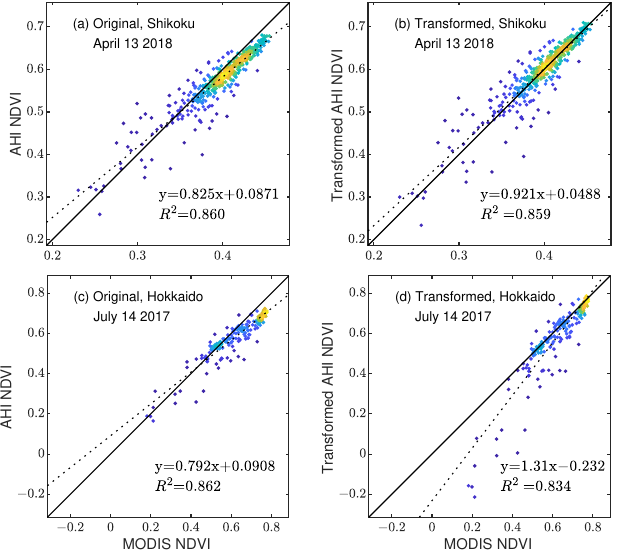
Figure 9. Density scatter plot of the aggregated NDVIs: ( a ) AHI vs. MODIS NDVI for Shikoku, April 13 2018; ( b ) transformed AHI vs. MODIS NDVI for Shikoku, April 13 2018; ( c ) AHI vs. MODIS NDVI for Hokkaido, 14 July 2017; and ( d ) transformed AHI vs. MODIS NDVI for Hokkaido, 14 July 2017.